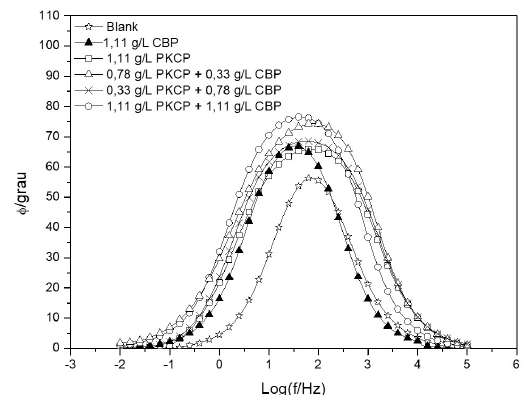
Figure 4. Bode phase angle plots for ASTM 1020 carbon steel in a 0.5 mol.L -1 HCl solution with various CBP and PKCP concentrations.